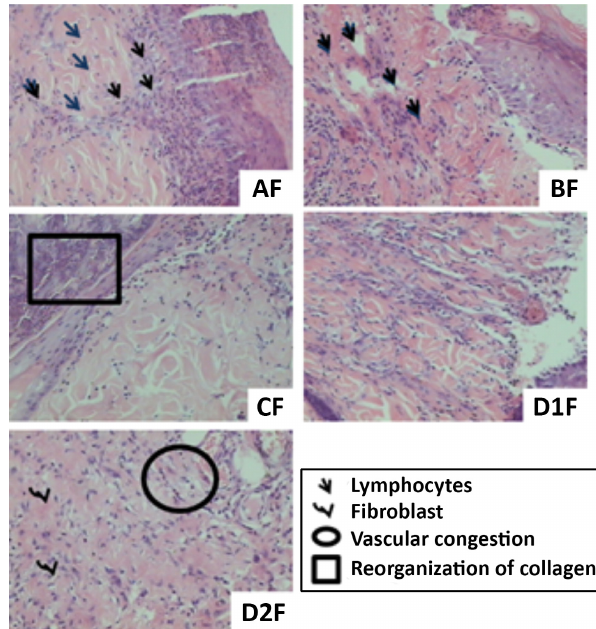
FIGURE 3 - Histological analysis of 7th day of treatment of skin wounds in rats. Key: AF – physiological serum, BF - collagenase, CF – natural PALY, D1F - PALY-CTAC, D2F – PALY-BKC, F – wound.